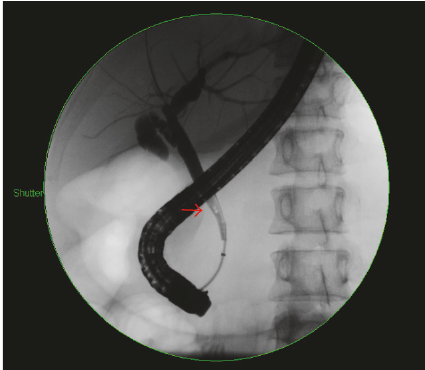
Figure 2: ERCP image of the gallstone (arrow) prior to